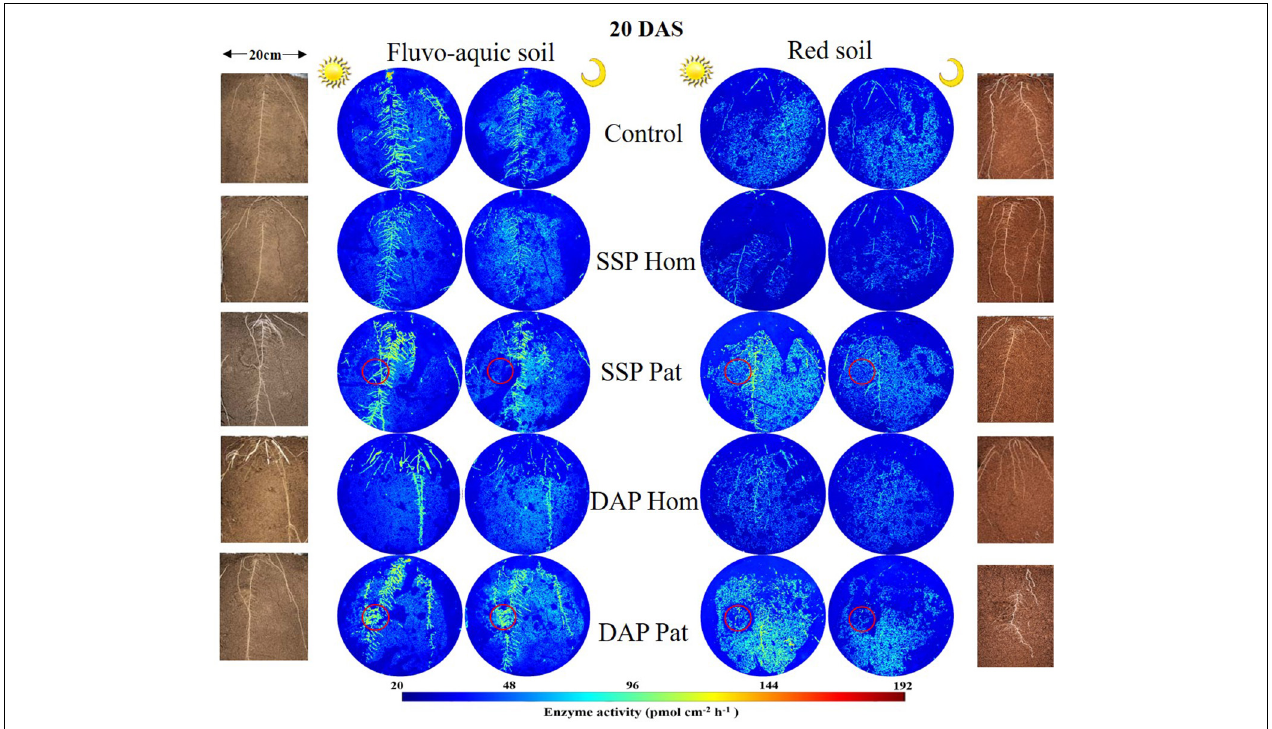
FIGURE 6 | Distribution of acid phosphatase (middle) and maize roots grown in rhizoboxes (left and right), in fluvo-aquic soil and red soil, on 20 DAS. The first and third columns of zymogram were taken on noon, and the second and fourth columns of zymogram were taken at midnight. Lines from top to bottom represent maize grown in soil with no phosphorus addition, superphosphate homogenized application in the whole soil, superphosphate localized application in the P-rich patches (red circle), diammonium phosphate homogenized application in the whole soil, diammonium phosphate localized application in the P-rich patches, respectively (red circle). The color map is proportional to acid phosphatase activity (pmol cm − 2 h − 1 ).